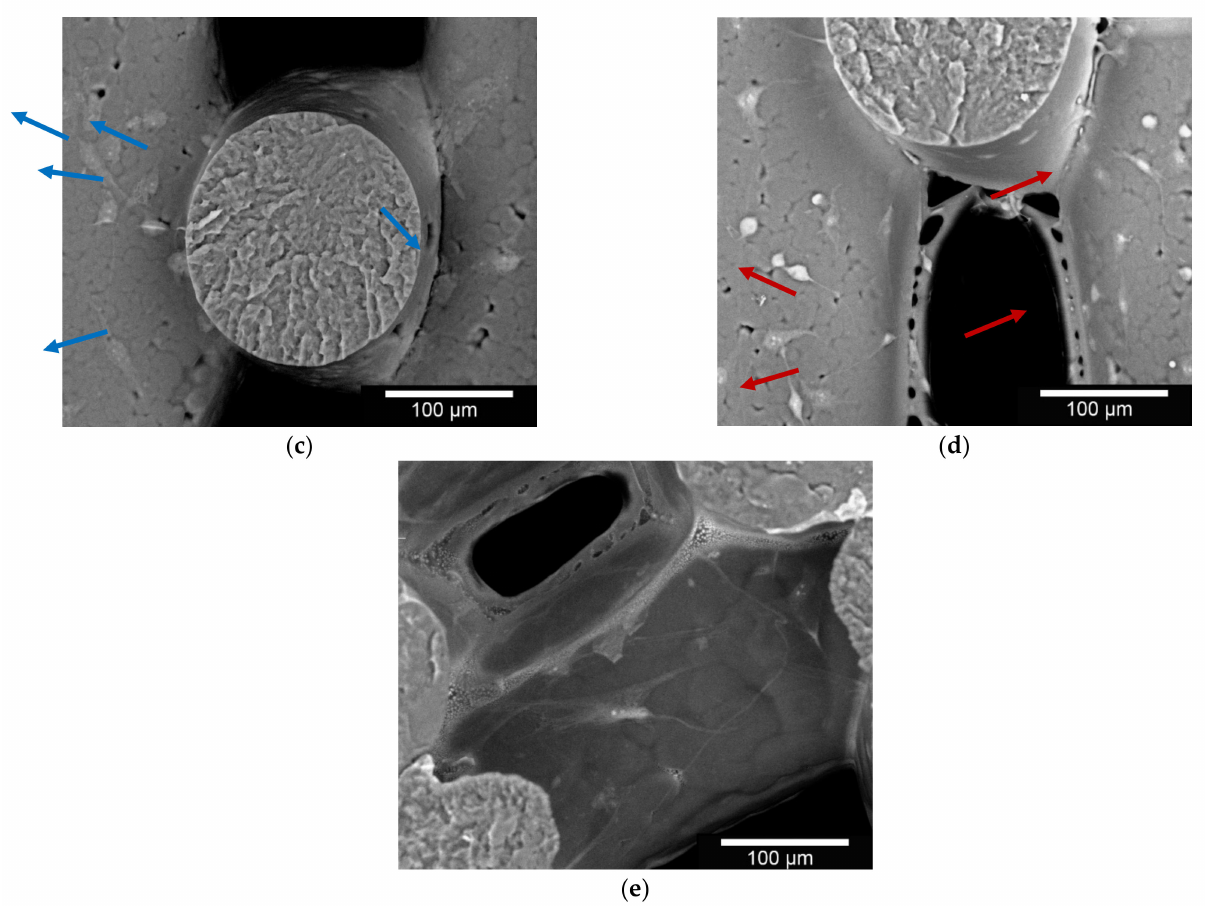
Figure 3. ESEM Images of the PCL scaffolds; ( a ): uncoated PCL; ( b ): collagen coated PCL (arrow); ( c ): MG-63 cells (blue arrows) on collagen coated PCL scaffolds; ( d ): MLO cells (red arrows) on collagen coated PCL scaffolds and ( e ): MSC (white arrows) on collagen coated PCL scaffolds; the cells were cultivated for 3 days on the scaffolds prior to ESEM measurements; Images taken with ESEM FEI Quanta 250 FEG, Large Field Detector, 20 kV acceleration voltage; 130 Pa; HFW 373 µ m (Figure 3a 746 µ